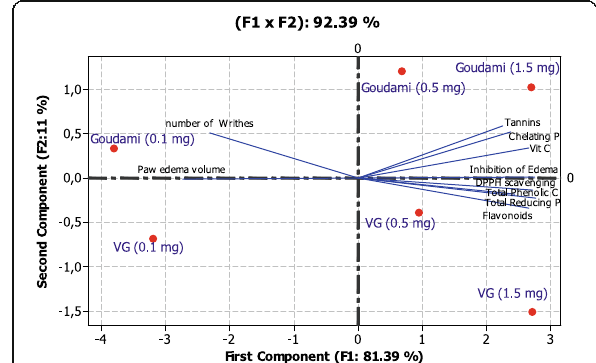
Fig. 3 Biplot (CP1 and CP2) describing the correlation between treatments, their antioxidant properties, anti-inflammatory and analgesic activities